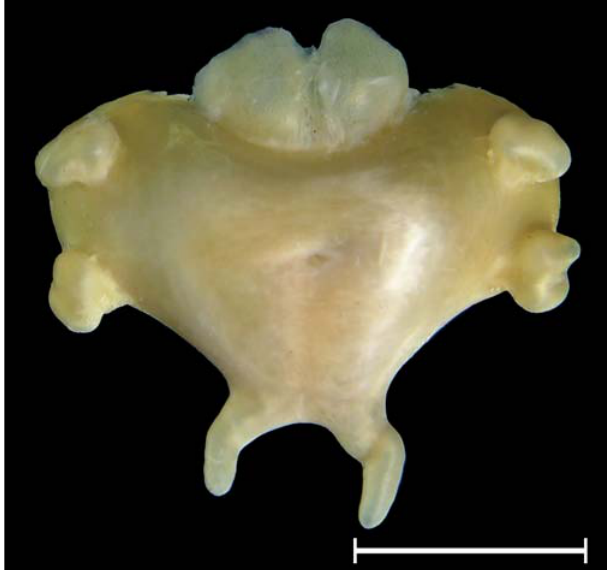
Fig. 14. Gas bladder of Leptodoras copei , ANSP 162461, 96.5 mm SL, in ventral view. Scale bar 5